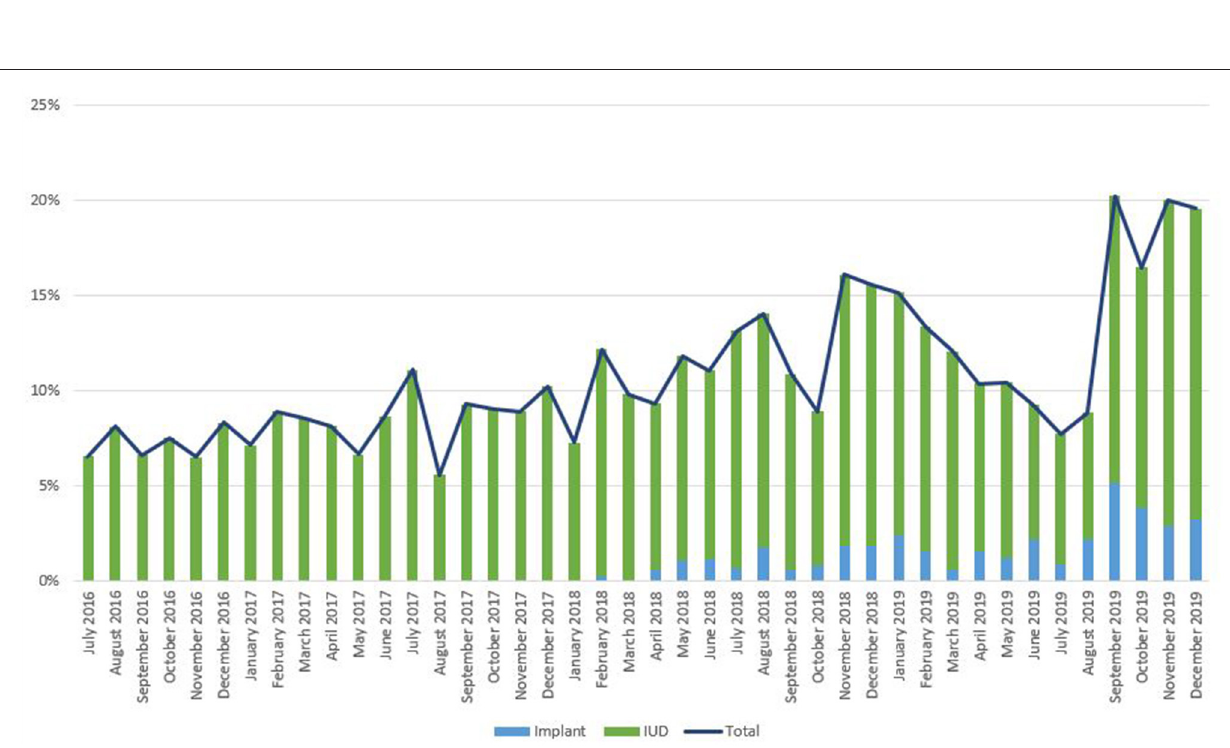
Frontiers in Global Women’s Health |